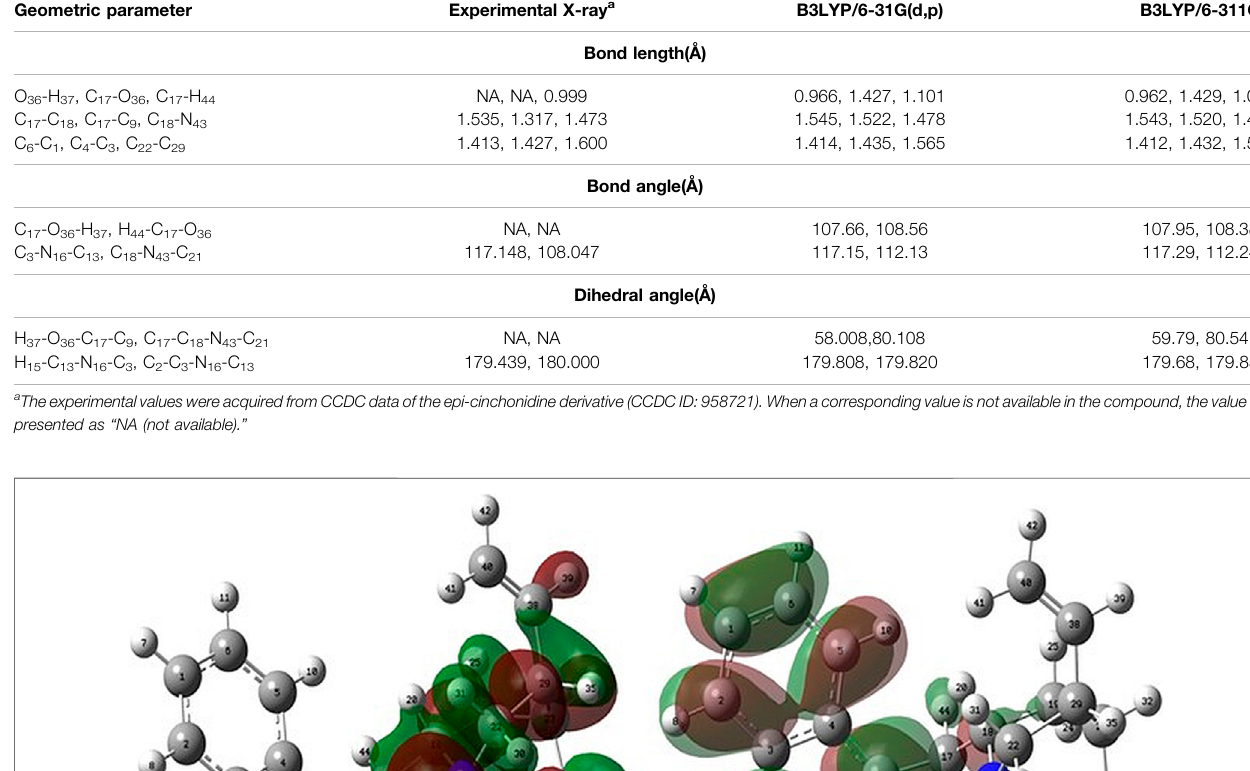
TABLE 1 | Optimized geometric parameters of epi-CD . Geometric parameter